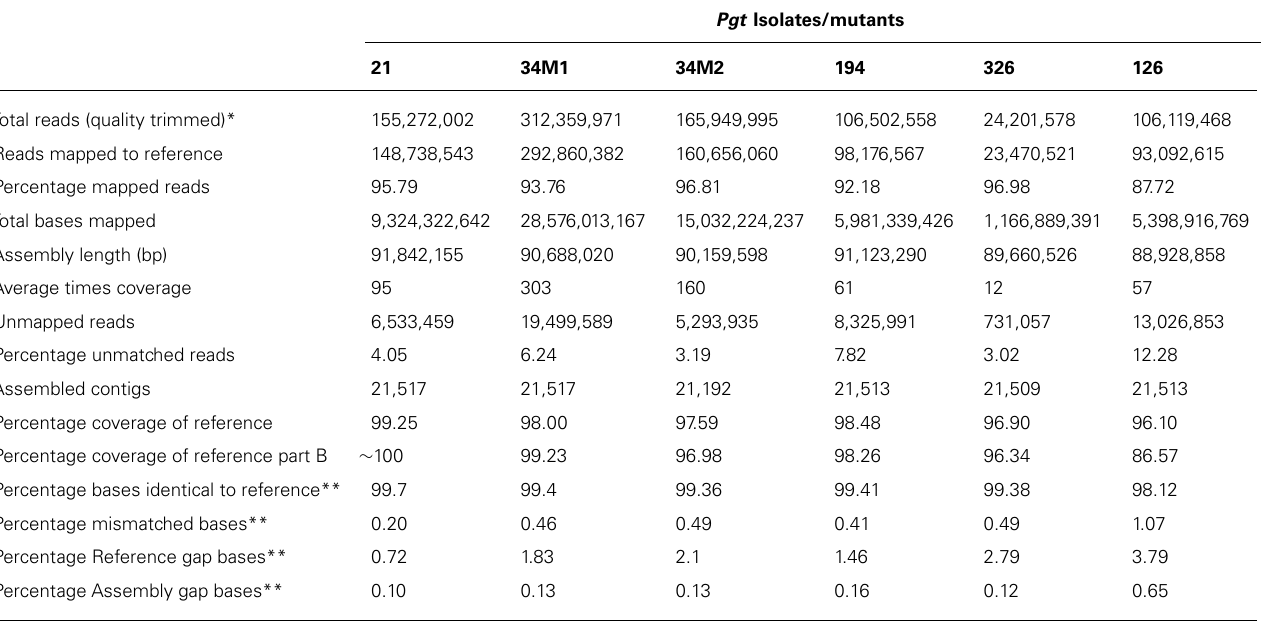
Table 3 | Mapping of Illumina DNA reads fromAustralian Pgt isolates to PGT21 reference